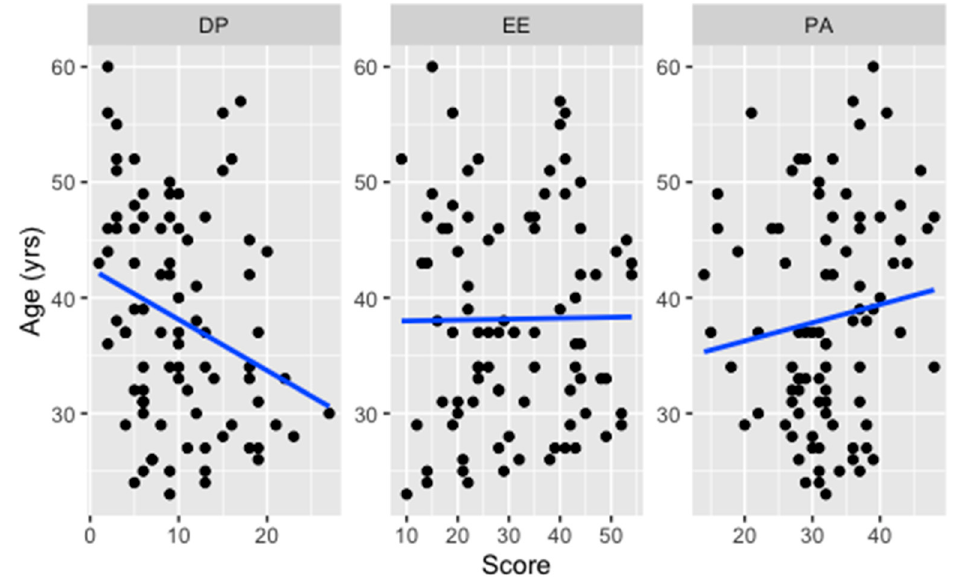
Figure 1. Correlation (solid line) between age and DP, EE and PA scores among nurses. Correlation between age and PA was also weak but diverging for nurses (rho= 0.13, p = 0.249) and healthcare assistants (rho= − 0.27, p = 0.264). Eventually, correlation between age and EE revealed a higher positive association in healthcare assistants (rho= 0.45, p = 0.061) than nurses (rho= 0.01, p = 0.924).